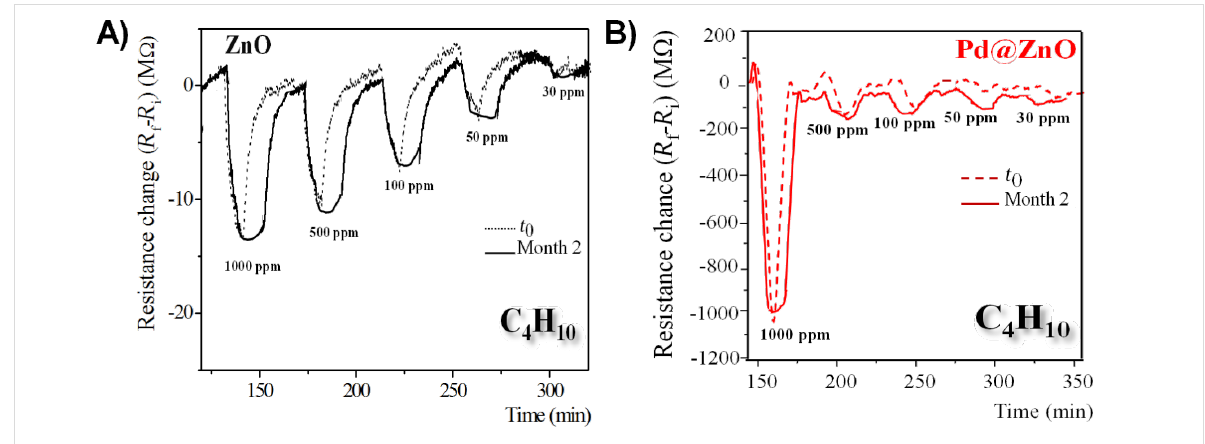
Figure 5: Time response of A) pristine ZnO and B) Pd-modified ZnO, detected at with as-prepared sensors ( t 0 ) and after two months, exposed to dif- ferent concentrations of butane (30–1000 ppm) at an operating temperature of 300 °C.